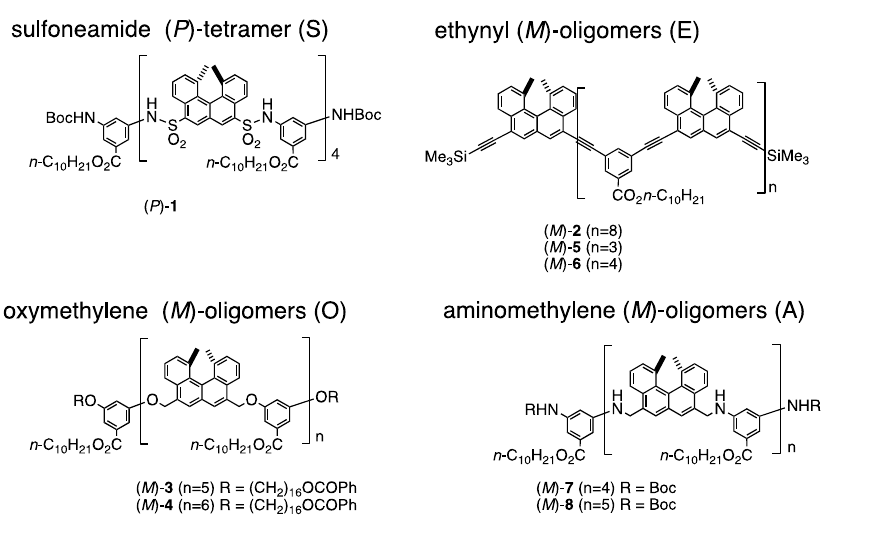
Figure 10. Chemical structures of helicene oligomers.